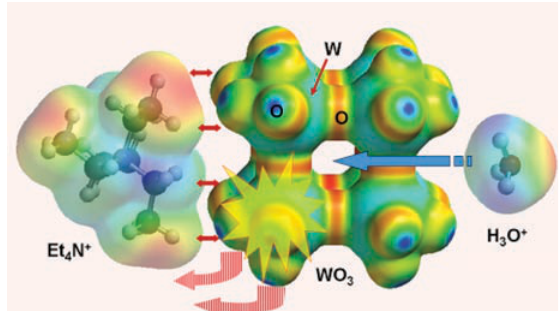
Figure 10. Comparison of structural features of WO cage, 3 intercalating H O+ cation and screening cation 3 Et4N+ causing dissociation of an octahedron WO6 and release of WO anion; potential: from 42- high – blue, to low -